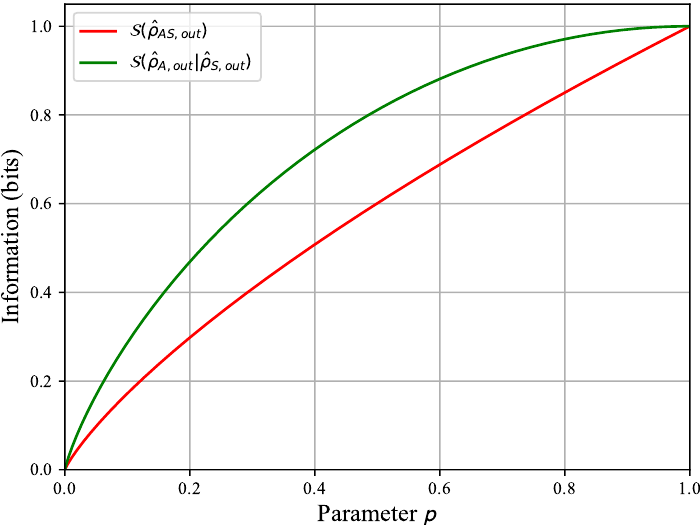
Figure 4. The Von Neumann entropy S ( ˆ ρ AS, out ) of the system AS in red and the conditional entropy